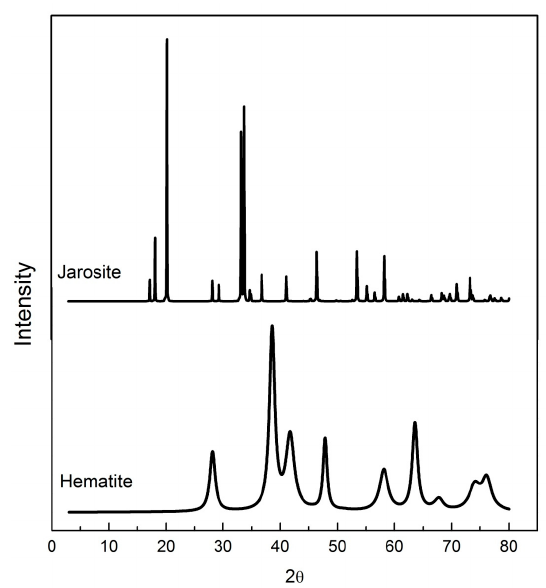
Figure A2. Effect of retention time on Fe(III) precipitation from solutions containing 6 g/L Fe(III), 15 g/L H 2 SO 4 , 11g/L Cl¯, and 30 g/L Cu(II) at 150 °C; ( a ) 0.0 g/L seed; ( b ) 15.0 g/L hematite seed. Data replotted from [26].